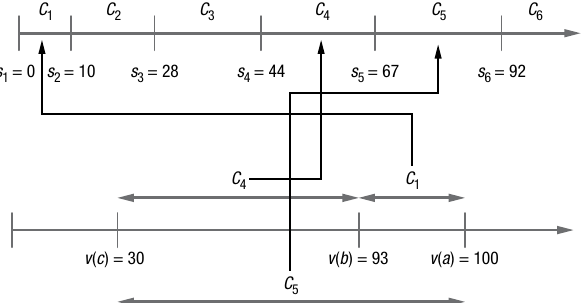
Fig. 3. Example of numerical representations of semi-orders for multiple thresholds Source : Mello et al . (2002: 57).